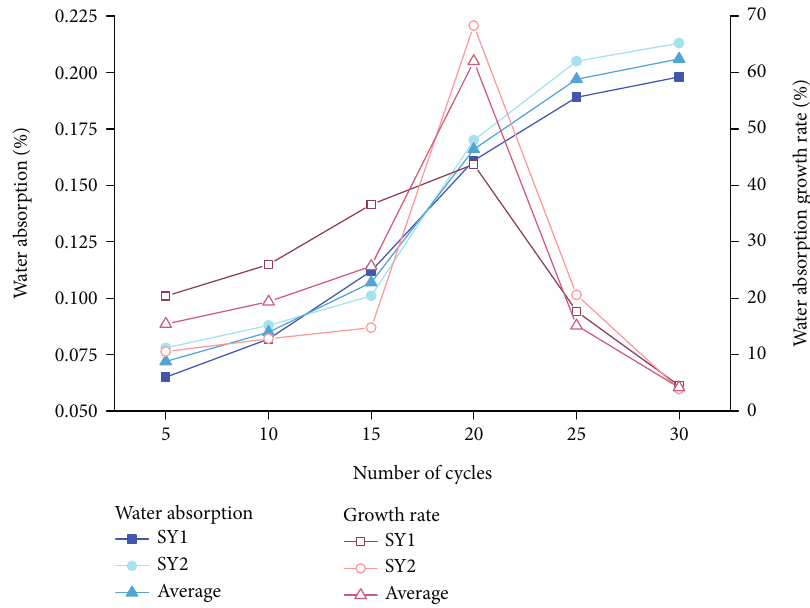
Figure 3: The variation law of water